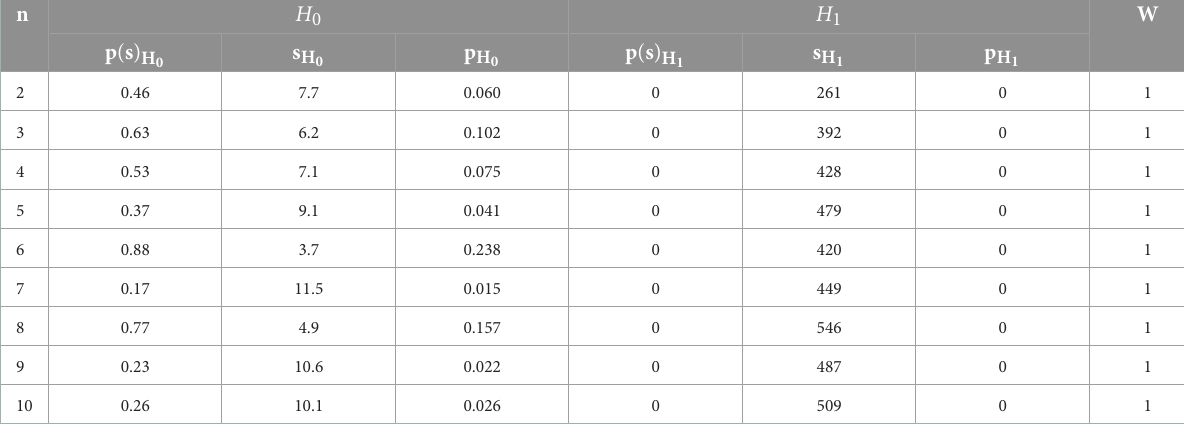
FIGURE8 Checking the uniformity of the sample volume n = 2.